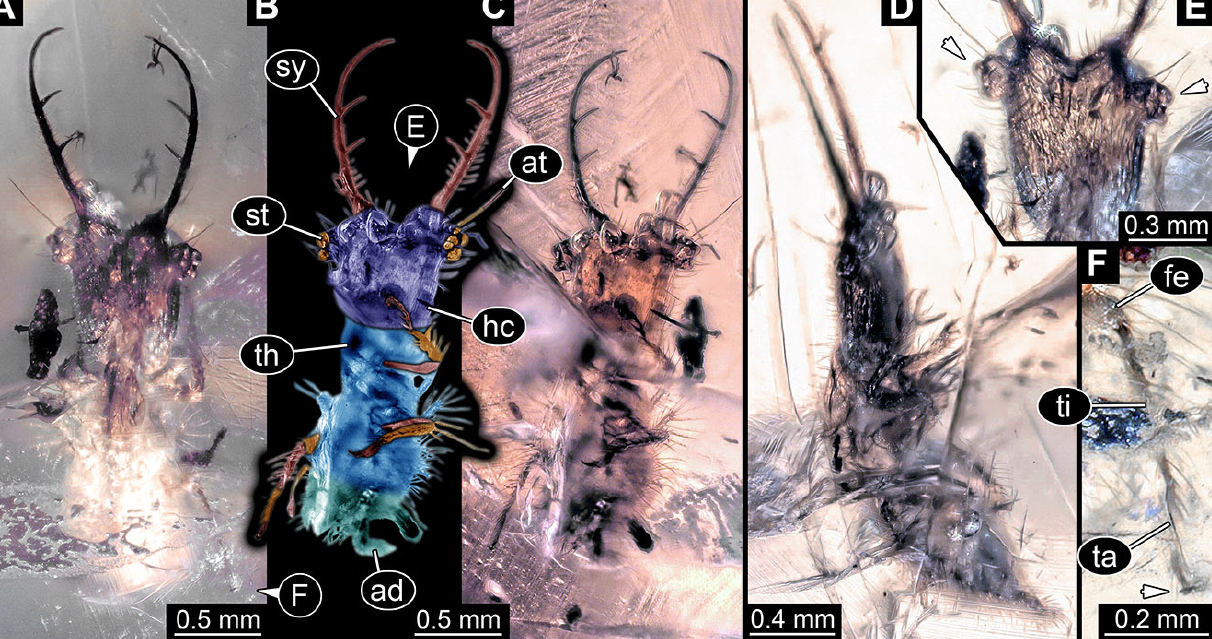
Figure 33. Fossil owllion larva, specimen 3246 (PED 0975), Cretaceous Kachin amber, Myanmar. ( A ) Overview, dorsal. ( B ) Color-marked version of ( C ). ( C ) Overview, ventral. ( D ) Overview, lateral. ( E ) Close-up on head capsule with fields of stemmata (arrows). ( F ) Close-up on trunk with locomotory appendage with claws (arrow). Abbreviations: ad = abdomen; at = antenna; fe = femur; hc = head capsule; st = stemmata; sy = stylet; ta = tarsus; th = thorax; ti = tibia. 36. Specimen 3247 (PED 1047), preserved in Cretaceous Kachin amber, Myanmar. Spec-